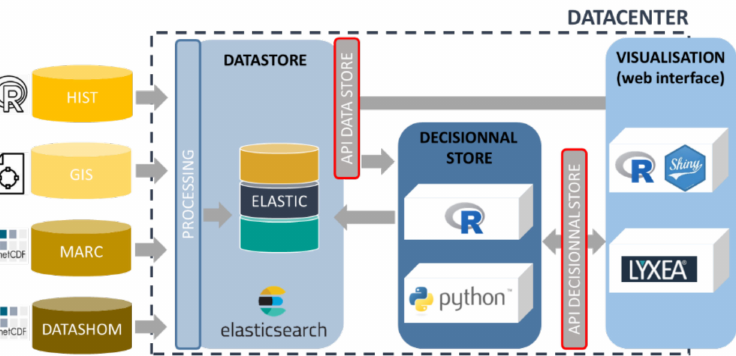
Figure 6. Simplified backend architecture of the FEWS. The MARC (https://marc.ifremer.fr/, ac- cessed on 15 July 2021) and DATASHOM (https://data.shom.fr/, accessed on 15 July 2021) platforms provide the X forecasted data.